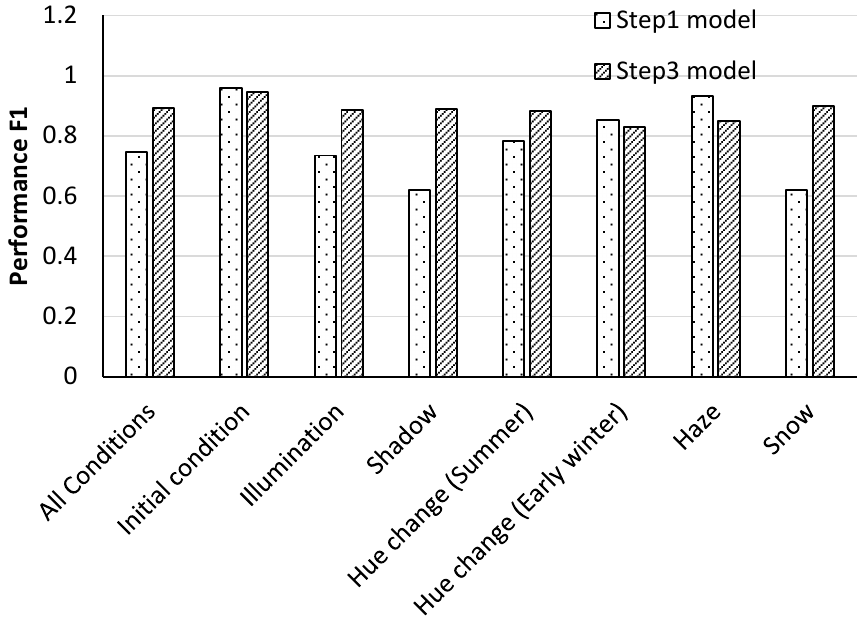
Figure 12. F1 score comparison between Step 1 (primary YOLOv3 model) and Step 3 (optimized YOLOv3 + DA model) under each condition and mixed conditions.